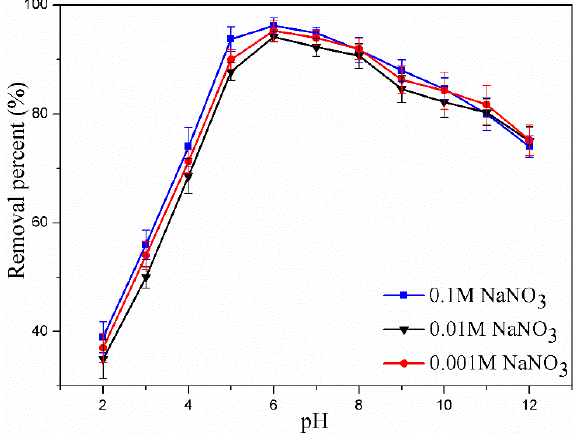
Figure 6. Influence of pH and ionic strength on the capturing U (VI) by PVKAP, C U(VI)initial = 36.0 mg L − 1 , T = 293 K.